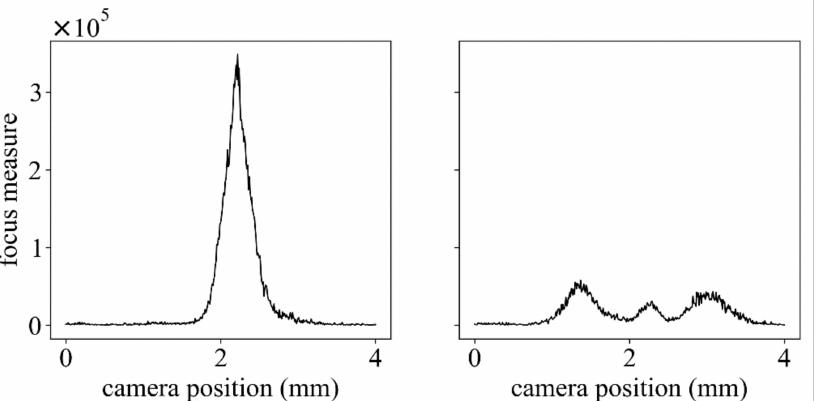
Figure 7. Focus measure distributions at the pixels in the small residue ( left ) and the large residue ( right ).